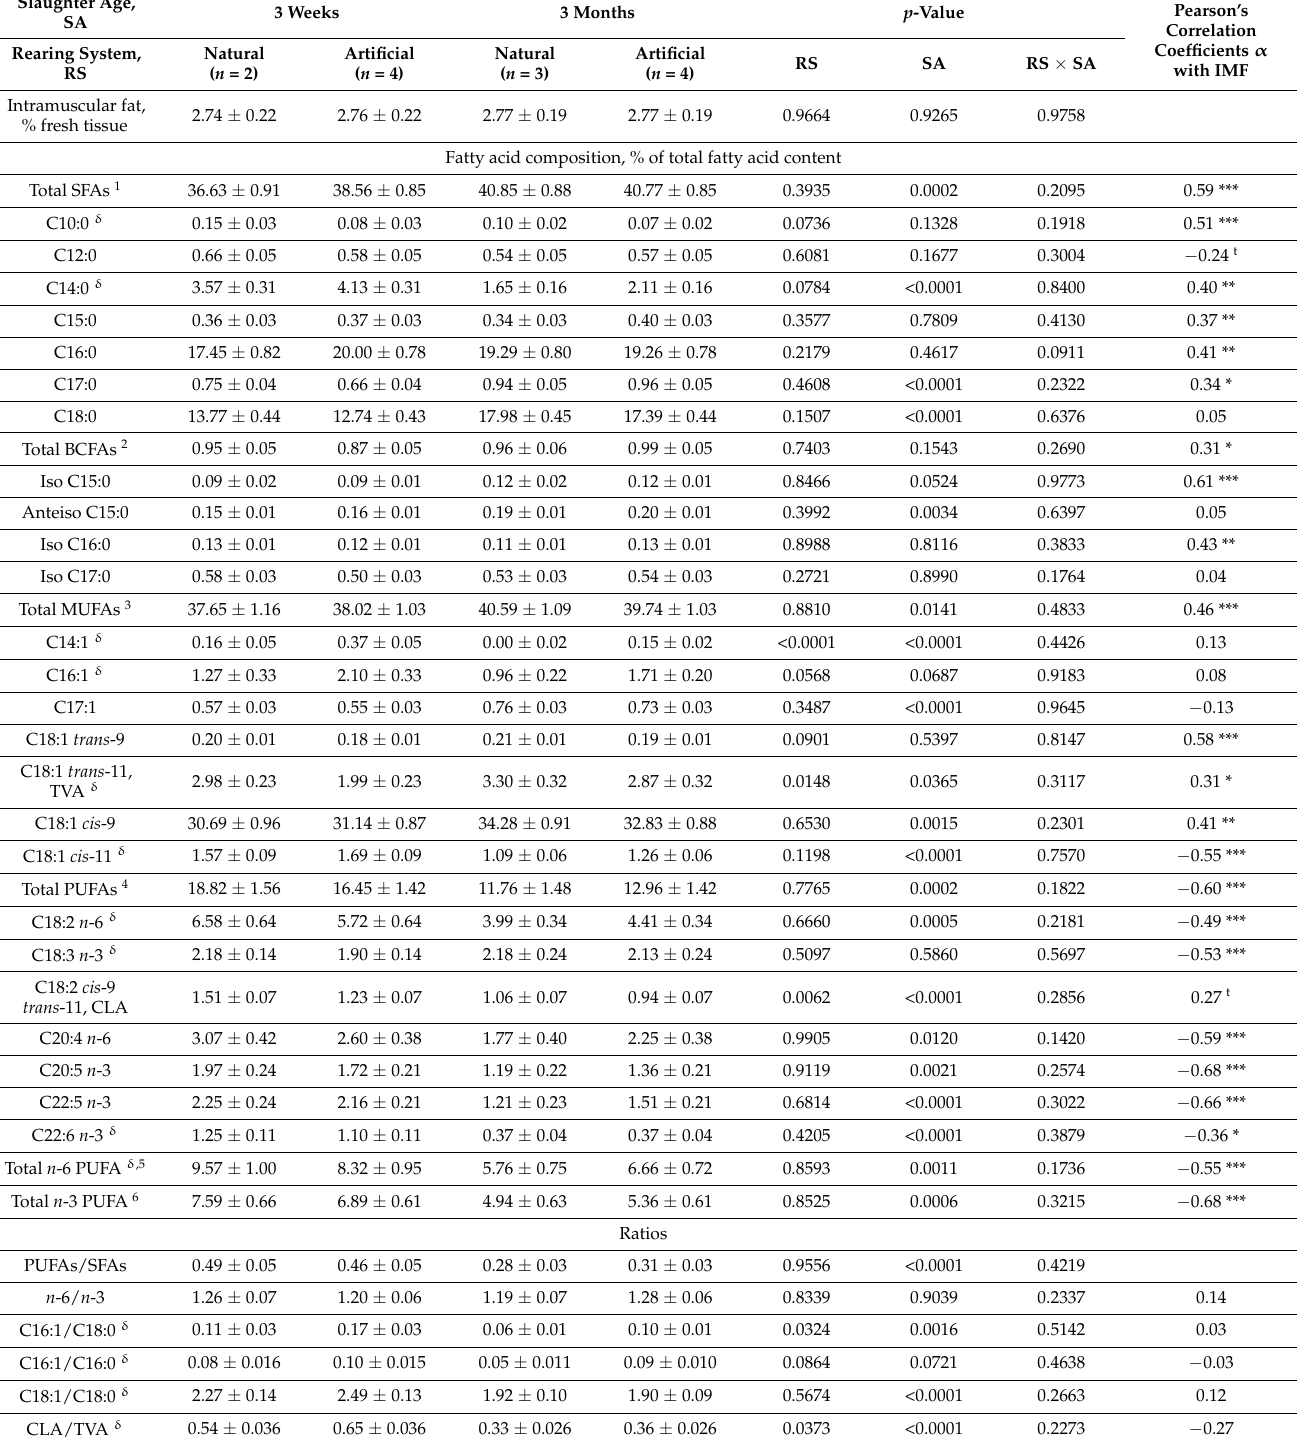
Table 2. Effect of rearing system and slaughter age on m. longissimus intramuscular fat (IMF) content (% fresh tissue) and fatty acid composition (12 animals per treatment; animals used in the sensory